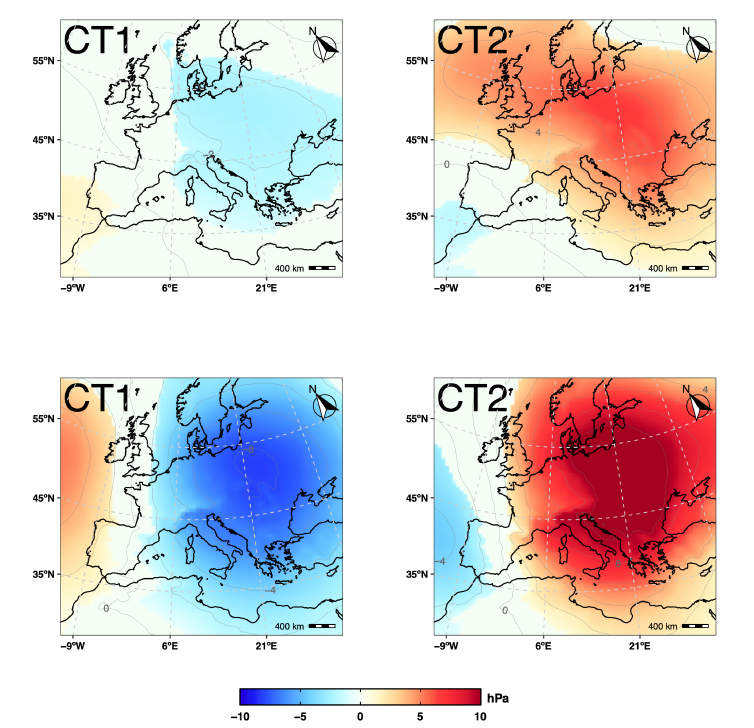
Figure 2. Differences in sea level pressure (SLP): ARCI − BASE ( top ) and ARI − BASE ( bottom ) in CT1 and CT2. Only the grid points with statistically significant differences ( p < 0.05) are